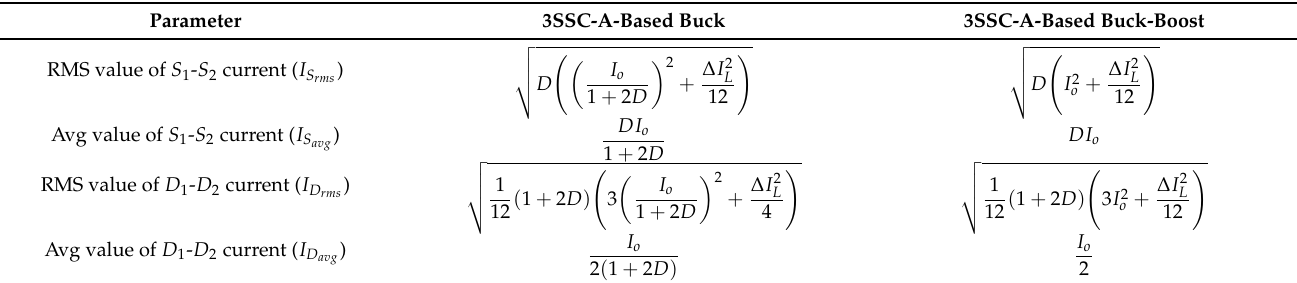
Table 4. Average and RMS Semiconductors Currents for 3SSC-A-based Buck and Buck- Boost